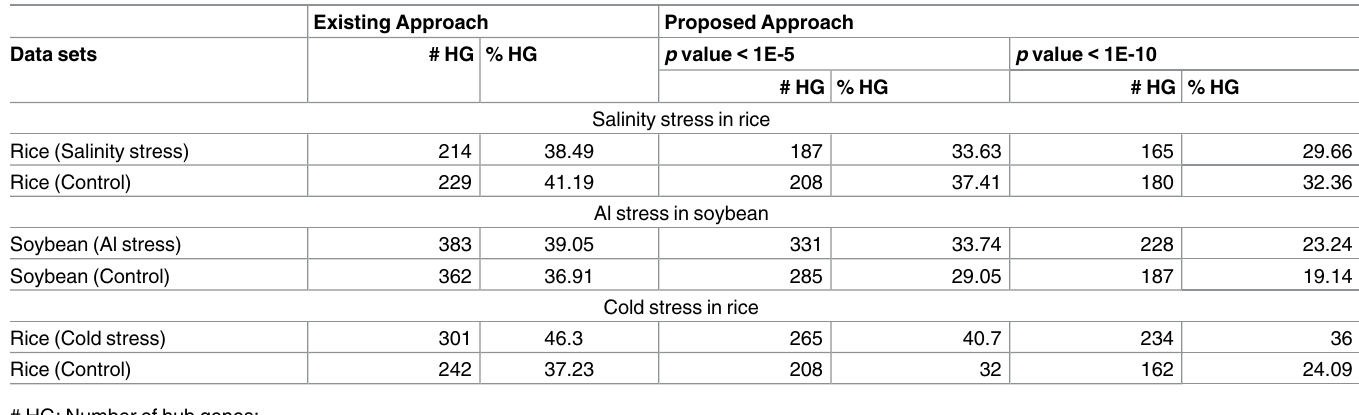
Table 5. Comparison of proposed and existing approach in terms of predicted hub